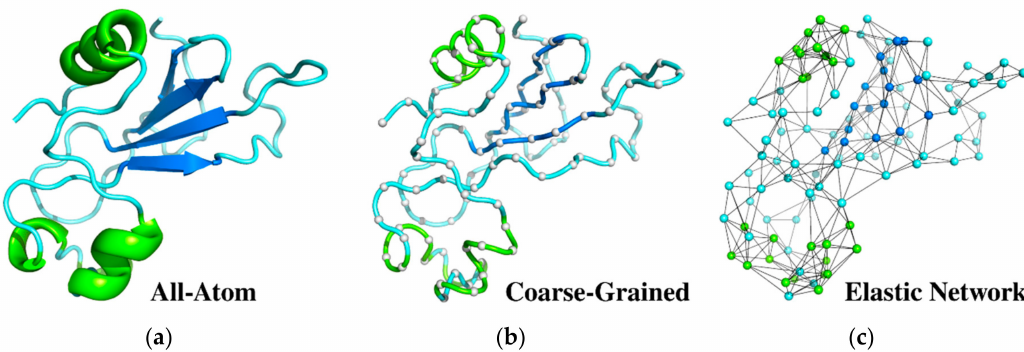
Figure 1. Different representations of protein structure (identifier of entry in the Protein Data Bank (PDB code): 1a2p) used as a reference state for structure dynamics studies. ( a ) All-atom structure used in molecular dynamics (MD) simulations shown as a ribbon diagram; ( b ) deeply coarse-grained model (gray balls represent a single center of interaction per residue connected by a tube) for Monte Carlo (MC) dynamics simulations; ( c ) coarse-grained elastic network model with spring-type constraints and nodes in the positions of C α atoms. Colors refer to the secondary structure assignment of protein fragments; helices are shown in green and β -strands are in dark